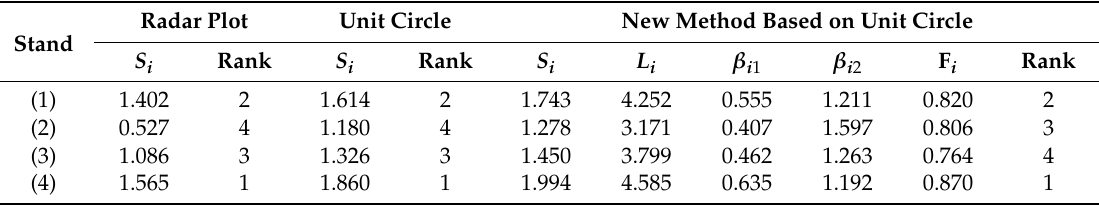
Table 3. The comprehensive evaluation value of different